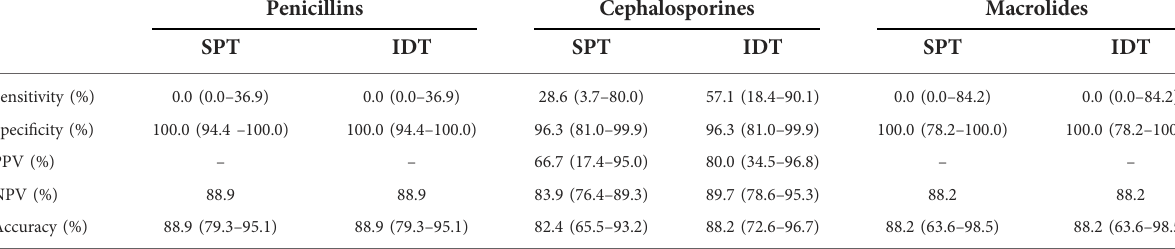
TABLE 3 Sensitivity, speci fi city and predictive values of penicillins, cephalosporins and